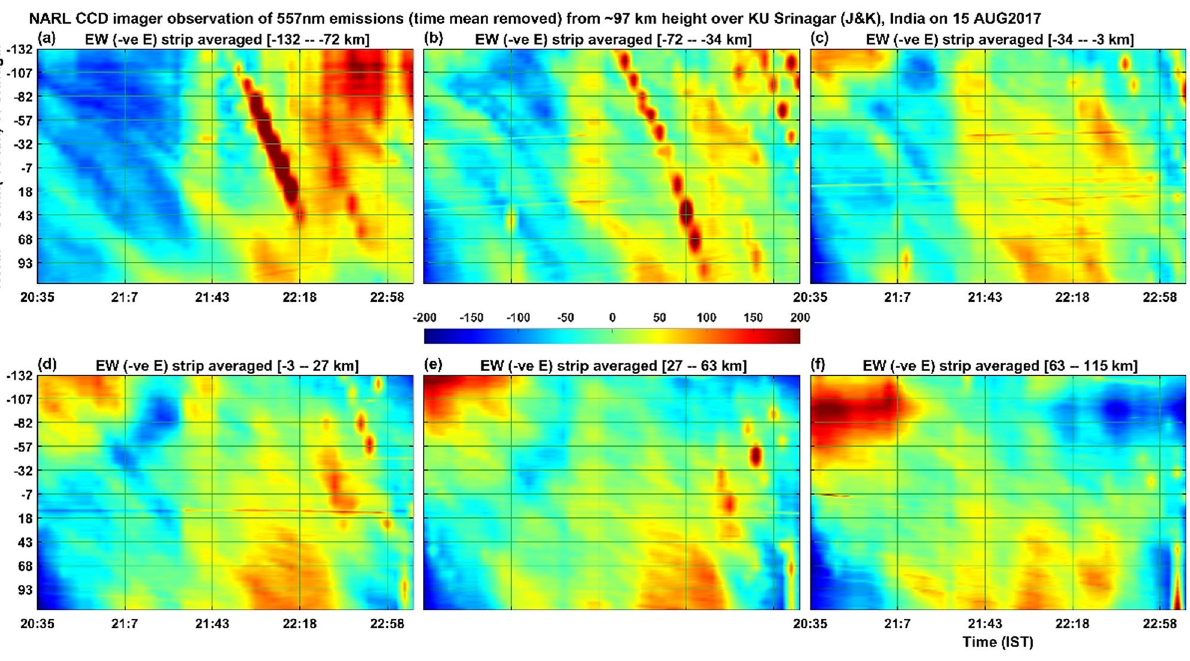
Figure 8. Illustrates the same as the Fig. 6 but for the 557.7 nm emissions of atomic oxygen from the height of about 97